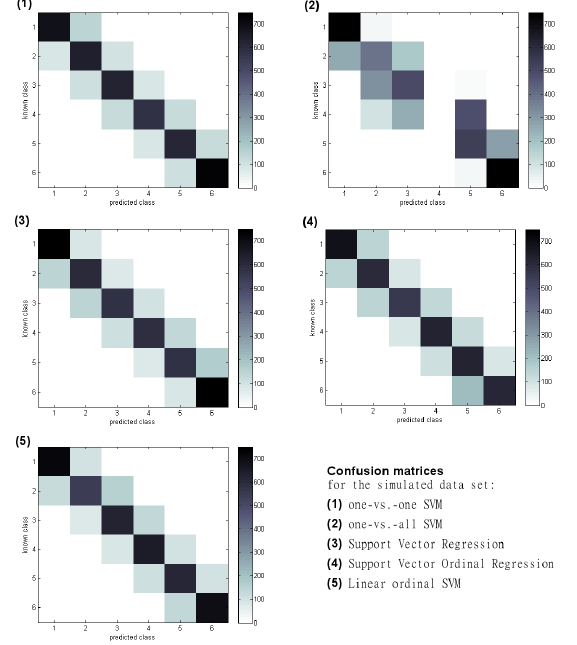
Figure 10: Confusion matrix of the prediction algorithms for the simulated data set with a pure ordinal